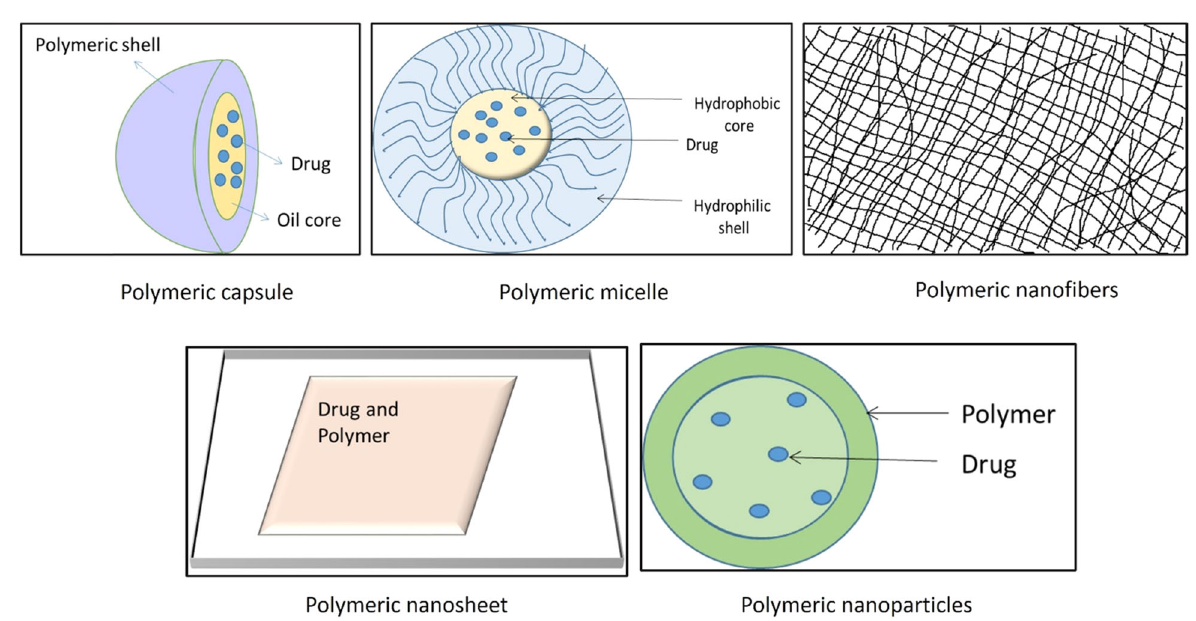
Fig. 3 Polymeric nanocarriers for delivery of